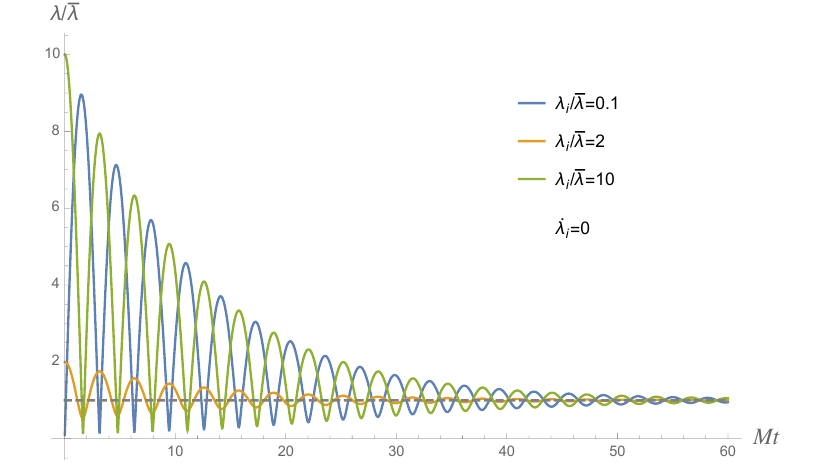
= 20, so that the time H